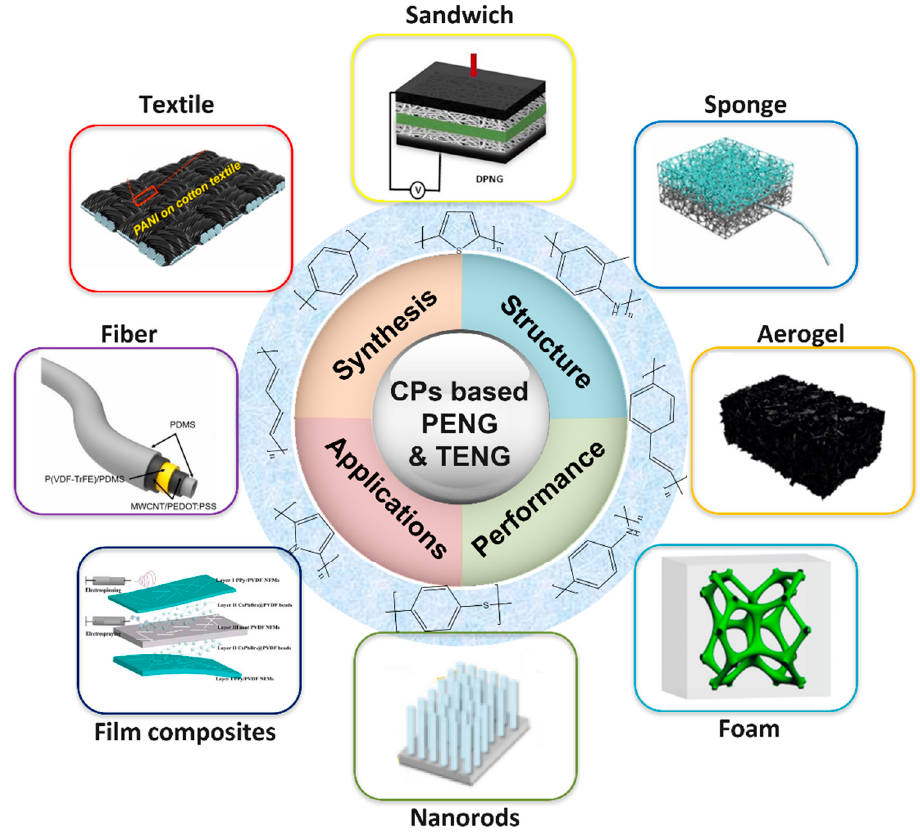
Figure 1. Schematic of overview of conducting polymers assisted nanogenerators with different structures for energy harvesting, including sandwich [26], sponge [27], aerogel [28], foam [29], film composites [30], filers [31], nanorods [32], and textile [33].